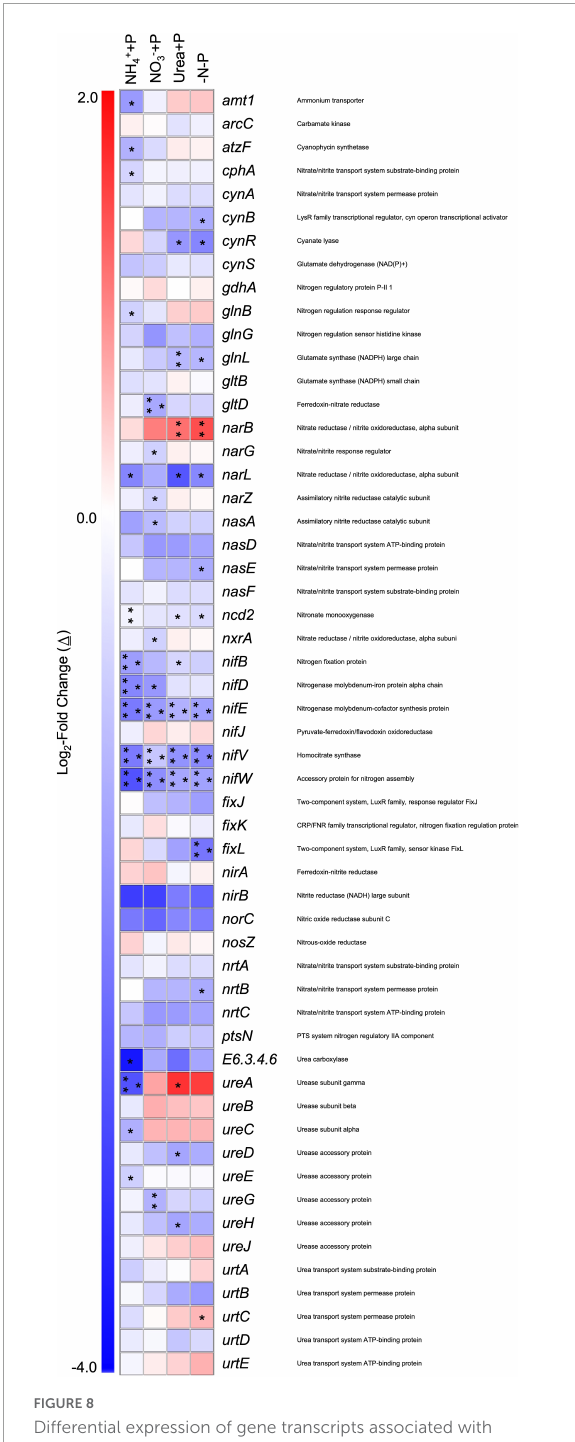
FIGURE8 Differential expression of gene transcripts associated with nitrogen metabolism and acquisition in experimental groups relative to the control/ − N + P. Heatmap representing log 2 -fold changes ( (cid:49) ) in nitrogen metabolism/acquisition gene expression in experimental groups with their corresponding gene products. Red or blue coloration corresponds to up or down – regulation of genes relative to the control, respectively. Statistical analyses were determined on transcriptomic data post-Sleuth analysis using the Wald test ( qval < 0.05 = *, 0.01 = **, 0.001 =